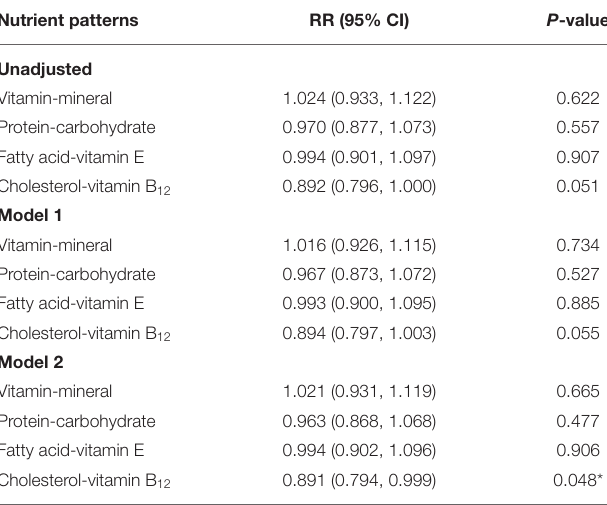
TABLE 2 | Log-binomial regression of nutrient patterns and MCI.